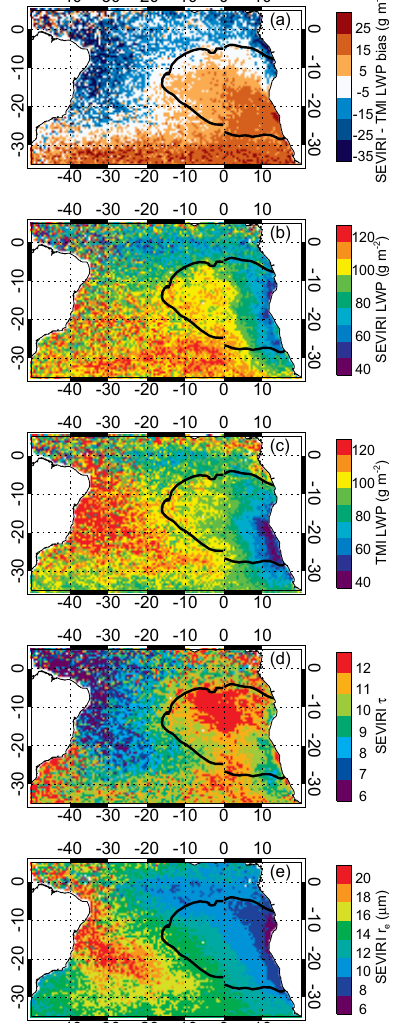
Figure 4. The 2-year-mean map of (a) SEVIRI minus TMI LWP bias, (b) SEVIRI LWP, (c) TMI LWP, (d) SEVIRI τ , and (e) SE- VIRI 1.6µm r e , for the overcast case (LCF ≥ 95% and τ > 3). The solid black contour denotes the identified Sc region. Rain-, ice-, and smoke-free conditions were applied.